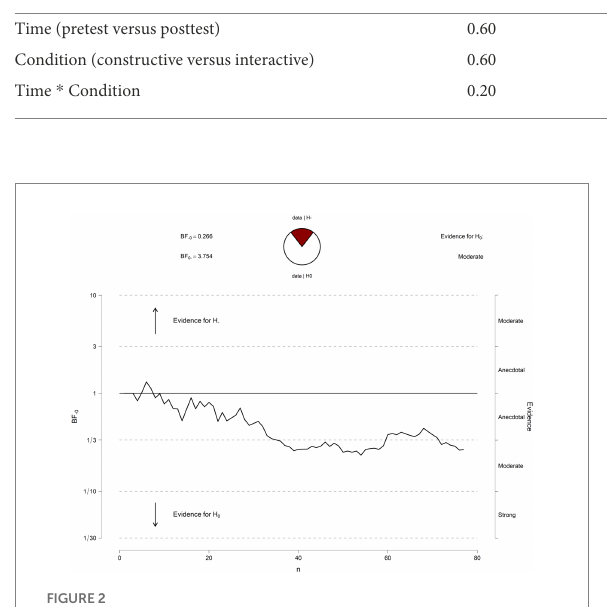
FIGURE 2 Results of the sequential analysis for the effect of the condition on